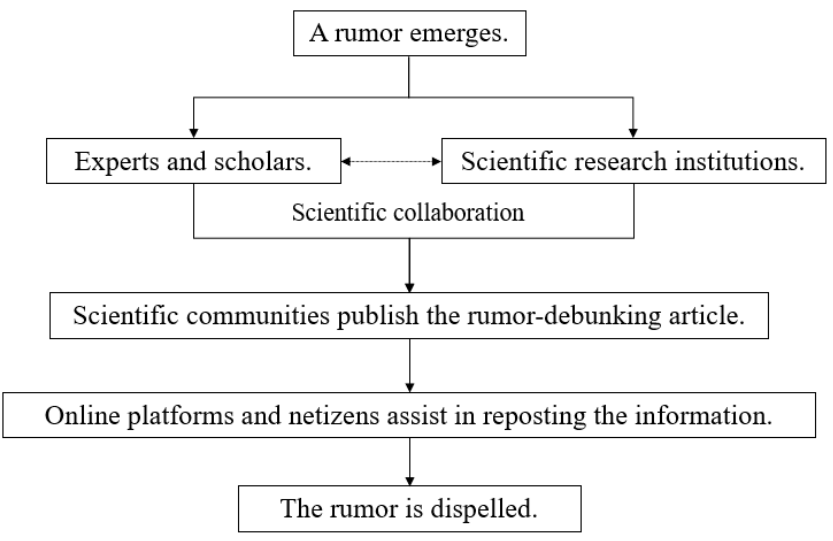
Figure 3. The “ scientific community- led” rumor -debunking